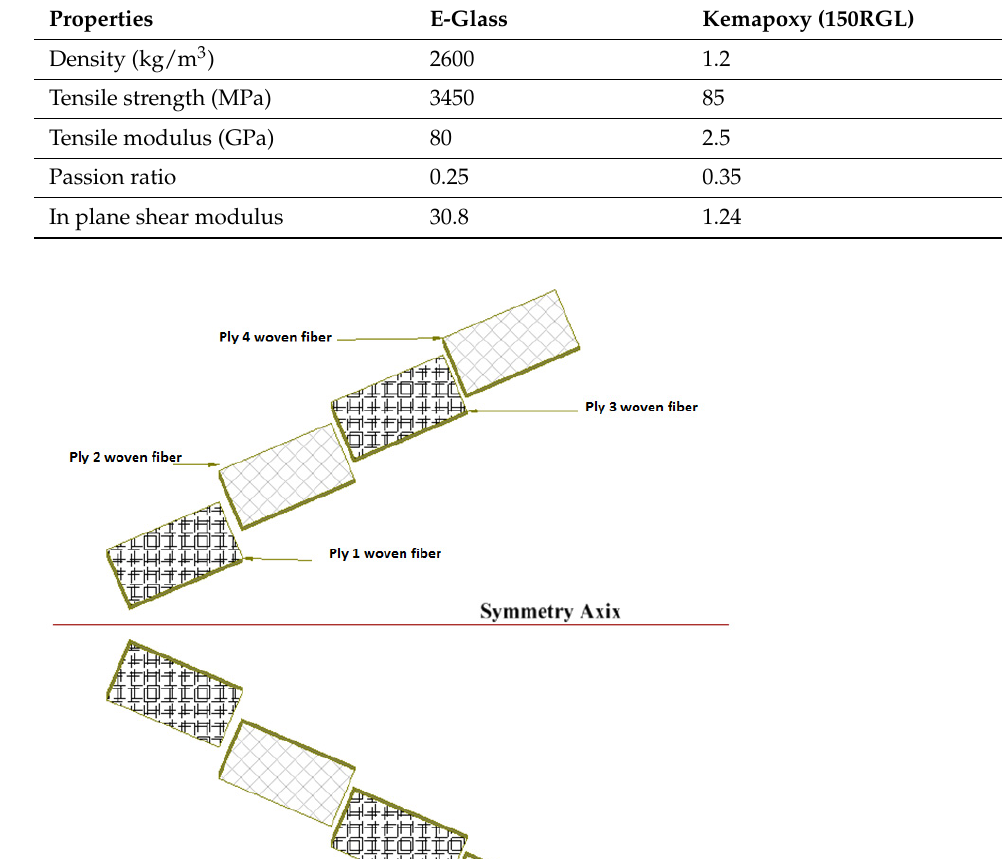
Table 1. Mechanical and physical properties of E-glass fiber and epoxy resin [32,37,38].